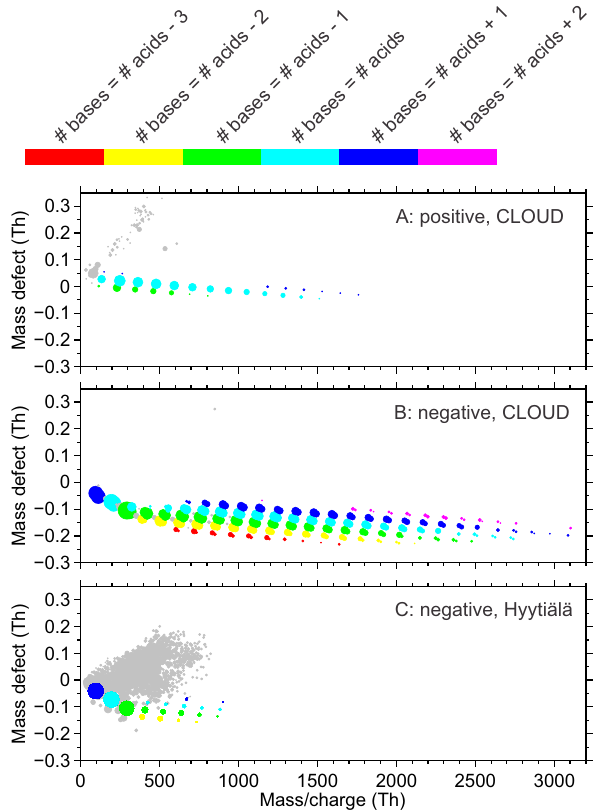
−0.3−0.2−0.100.10.20.3 h ) T ( ss a M Figure 8. Mass defect diagrams of ion mass spectra during new- particle formation. The NH 3 –H 2 SO 4 ion clusters are colored; other ions are shown in grey. The colors reflect the relative numbers of acids and bases in the cluster, counting NH 3 , HSO − , HSO − 4 5 and SO − as bases, and H 2 SO 4 as acid, and not counting NH + . 5 4 (a) Positively charged clusters (NH 3 ) m · (H 2 SO 4 ) n · NH + during 4 new-particle formation at CLOUD at [NH 3 ]/[H 2 SO 4 ] = 185, tem- perature ( T ) = 19 ◦ C. Other ions (in grey) are mostly organic, N- containing contaminants, such as pyridine, charged by protona- tion. (b) Negatively charged clusters (NH 3 ) m · (H 2 SO 4 ) n · HSO − 4 and (NH 3 ) m · (H 2 SO 4 ) n · HSO − during new-particle formation 5 at CLOUD at [NH 3 ]/[H 2 SO 4 ] = 118, T = 19 ◦ C. (c) Neg- atively charged clusters (NH 3 ) m · (H 2 SO 4 ) n · HSO − during a 4 new-particle formation event in the boreal forest, Hyytiälä, at [NH 3 ]/[H 2 SO 4 ] = 485, T = 1 to 5 ◦ C. Most of the signal of other ions (in grey) has a more positive mass defect and likely arises from ions containing mainly a variety of oxidized